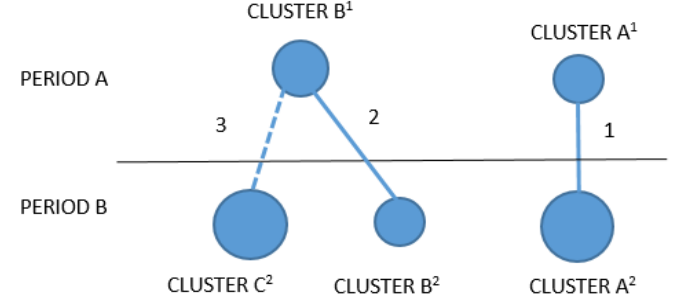
Figure 4. Example of evolution areas.